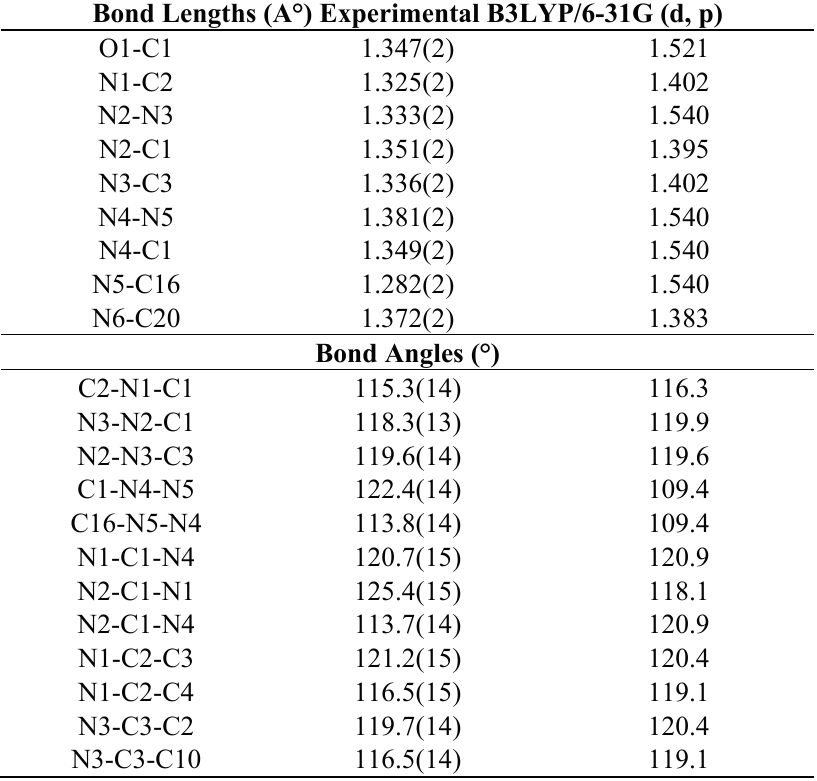
Table 5. Selected molecular structure parameters of compound 3